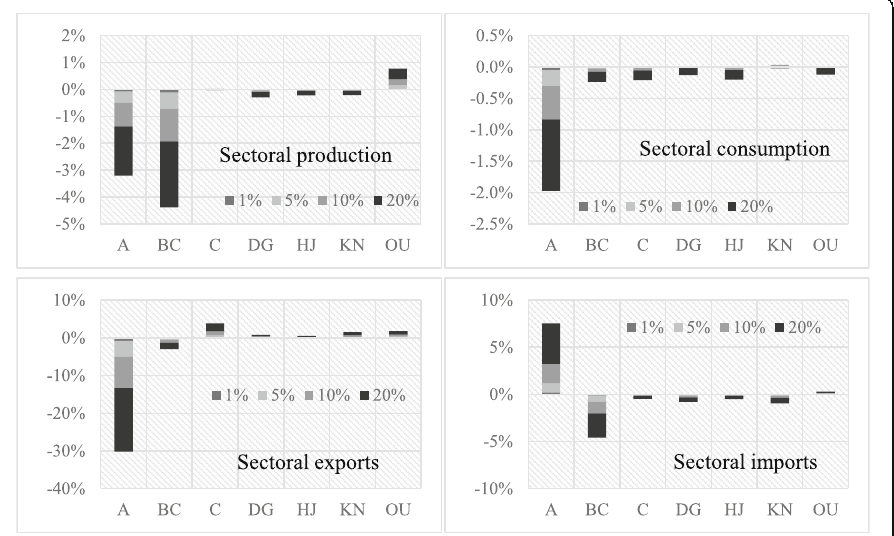
Fig. 10 Simulated sectoral effects of government revenue neutral tax on use of nitrogen fertilizer (product of chemical industry) in agricultural production (neutralization based on decrease of labor tax burden). (Source: authors calculations based on CGE model simulations